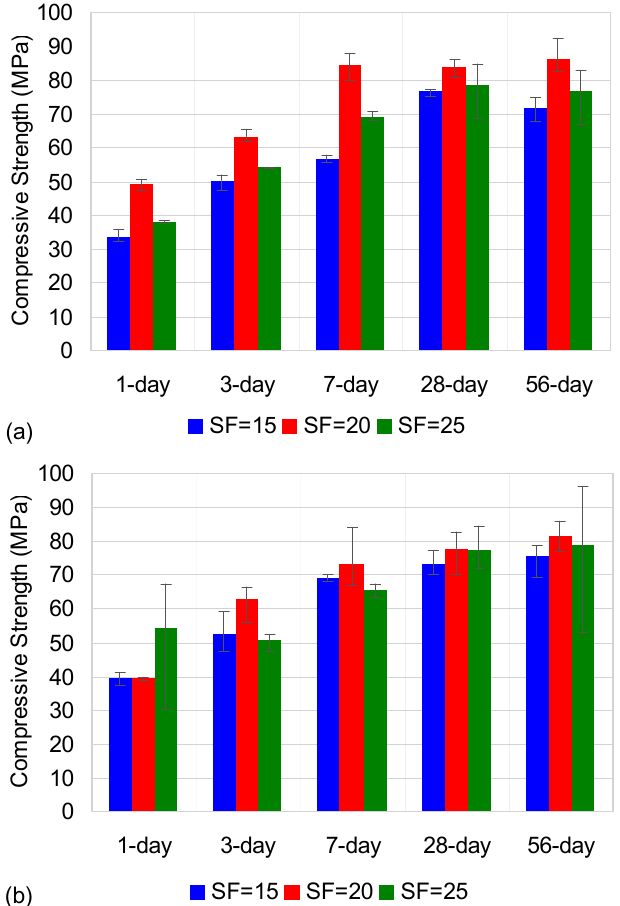
Figure 9. Effect of the WB and curing temperature on compressive strength at WB = 0.22: ( a ) 23 ± 2 °C and ( b ) 40 ± 2 °C.